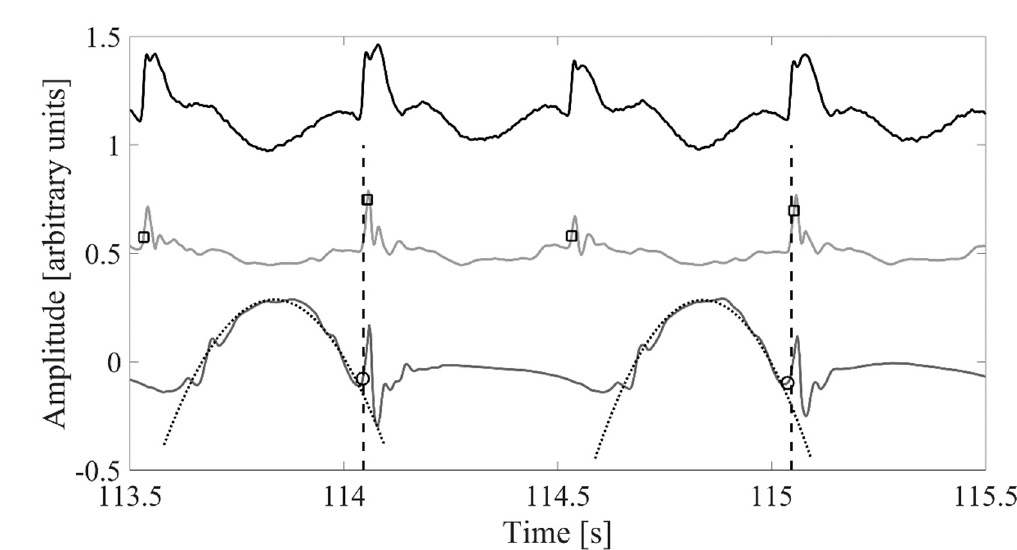
Figure 1. Visualization of the heel-strikes detected based on concurrently recorded ground reaction forces (vertical ground reaction—force black solid line), waist-worn inertial measurement unit (IMU) vertical acceleration (lightest grey solid line) and waist-worn IMU sagittal plane angular velocity (dark grey solid line). Dashed black vertical line indicates right foot heel-strike based on ground reaction forces. Black square indicates heel-strike based on the waist-worn IMU. Black circle indicates heel-strike based on the ankle-worn IMU recording. Dotted gray line shows the fitted parabola used to define heel-strike events based on the ankle-worn IMU recording.